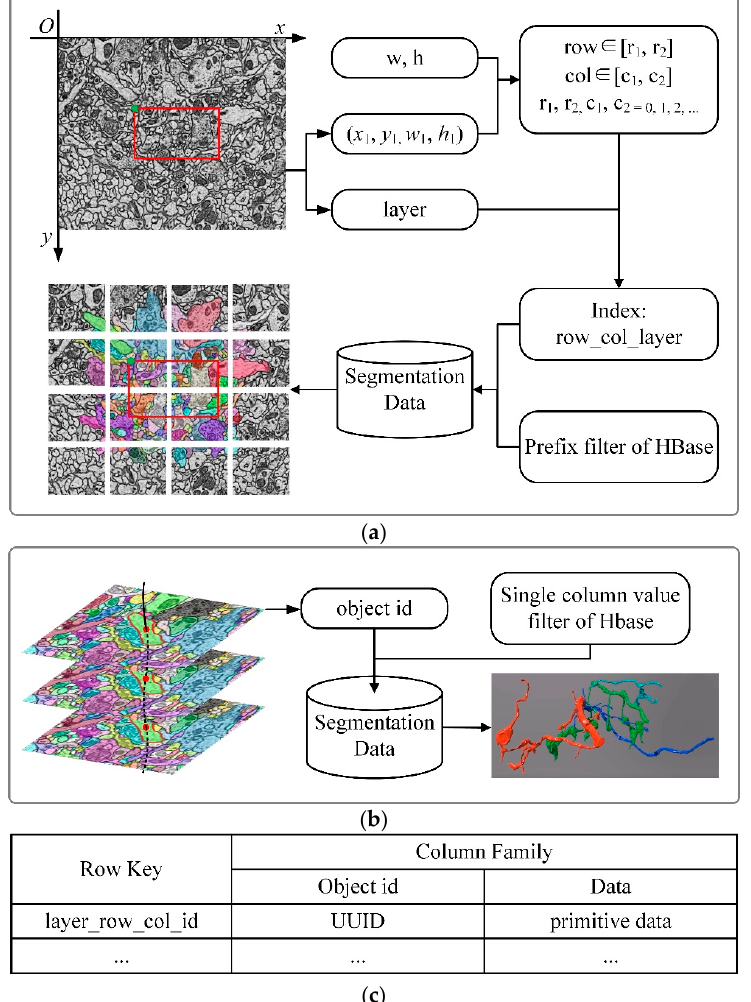
Figure 6. The flow of segmentation retrieval for 2D retrieval and 3D retrieval. ( a ) The flow of 2D retrieval. The meaning of parameters (w, h, x1, y1, w1, h1, layer) is the same as what is mentioned in